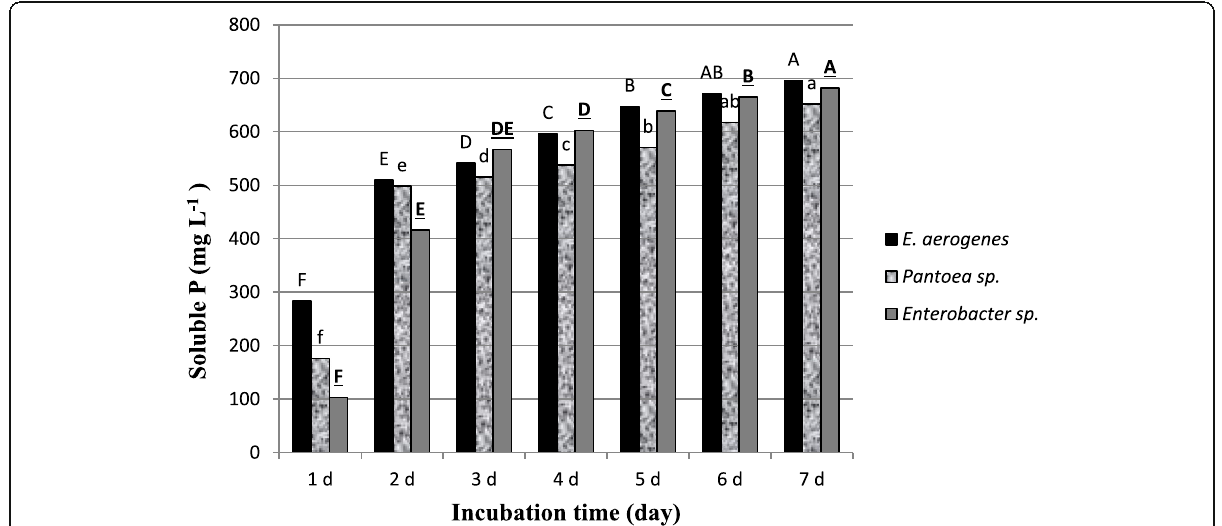
Fig. 2 The effect of incubation time on P solubilization rates on NBRIP media. Columns marked with the same alphabetical letter(s) within comparable means in the same isolate ’ s column do not differ significantly using the revised L.S.D. test at 0.05